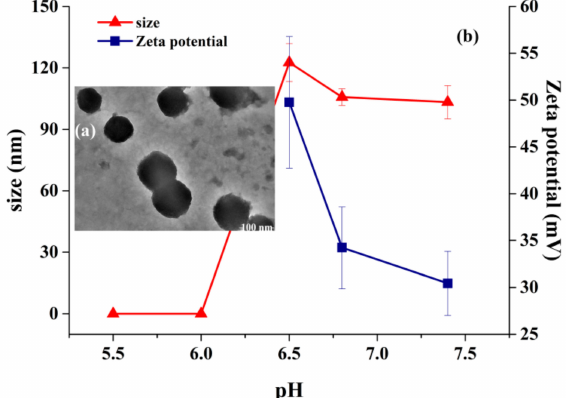
Figure 3. ( a ) TEM images of PEG-PBAE (scale bar, 100 nm) and ( b ) size distribution and Zeta potential changes of blank PEG-PBAE at di ff erent pH values of 7.4, 6.8, 6.5, 6.0, and 5.5 ( n =